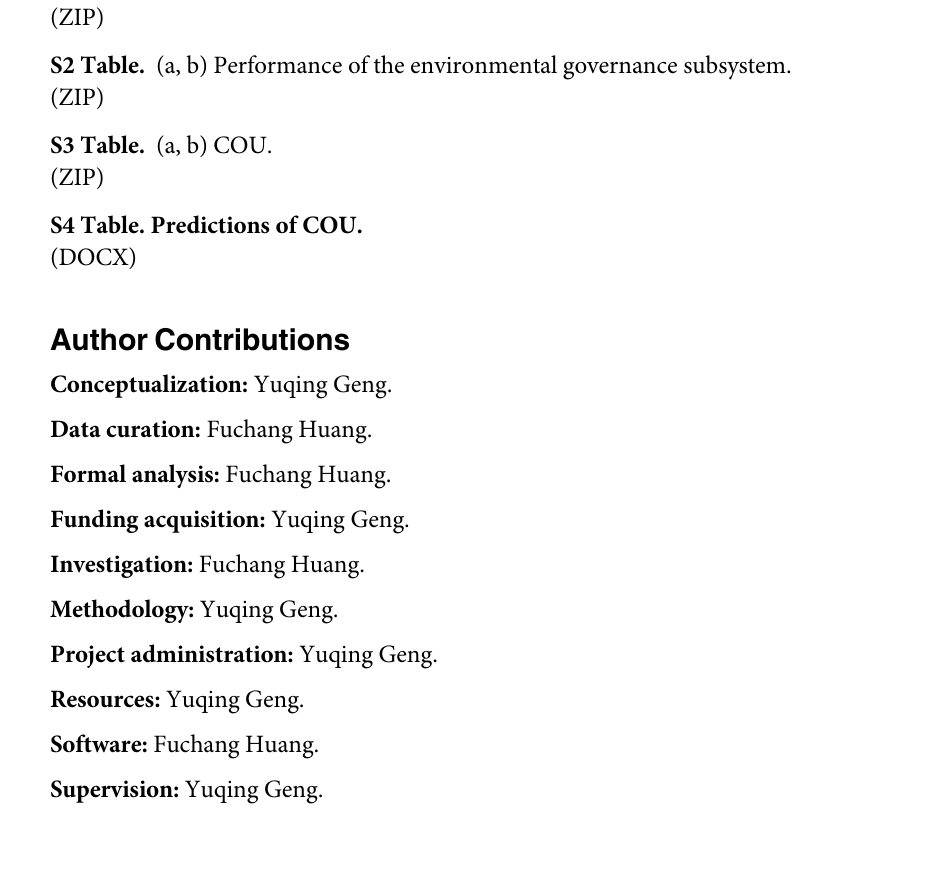
S1 Table. (a, b) Performance of the higher education subsystem. (ZIP) S2 Table. (a, b) Performance of the environmental governance subsystem. (ZIP) S3 Table. (a, b) COU. (ZIP) S4 Table. Predictions of